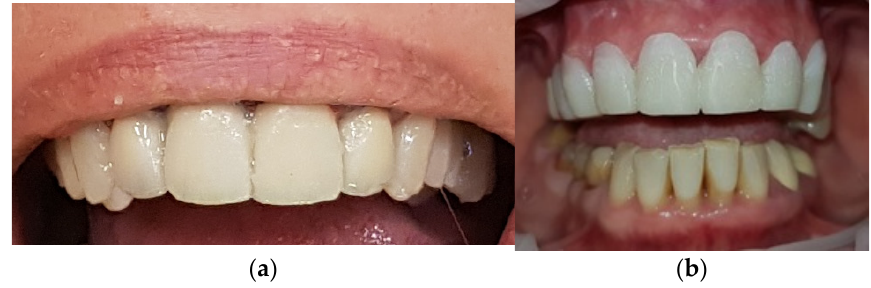
Figure 3. Planning the surgical treatment outcomes: ( a ) Initial mock-up; ( b ) Surgical guide.